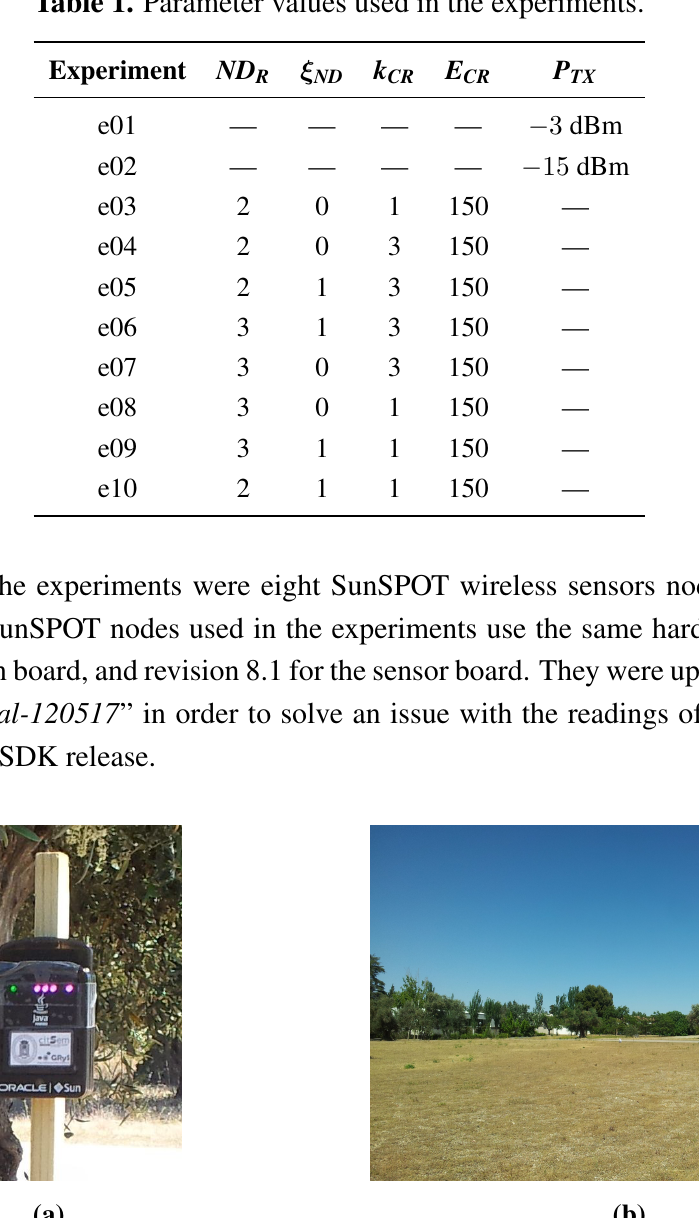
Table 1. Parameter values used in the experiments.